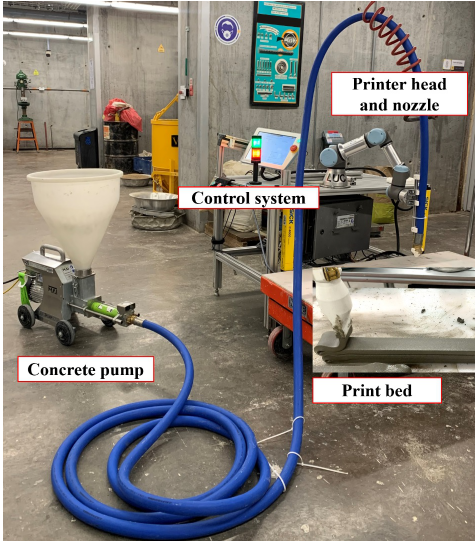
Figure 2. Printing system (progressive cavity pump-MAI®2PUMP-PICTOR, and robotic